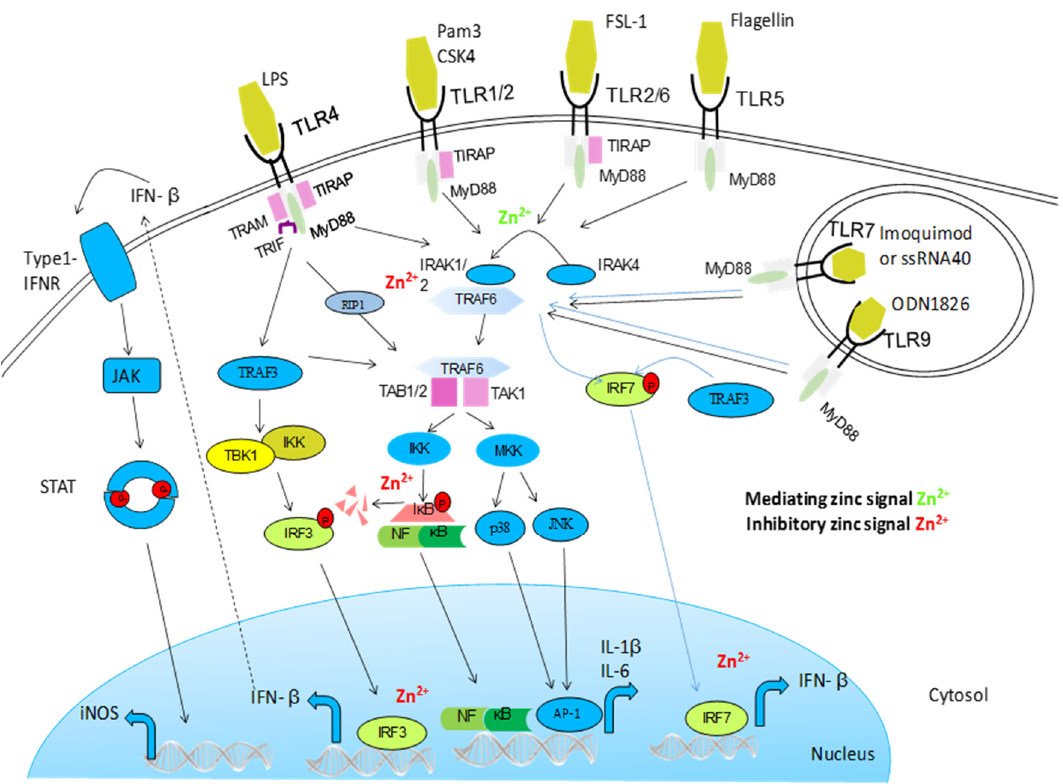
Figure 1. Activation of Toll-like receptor (TLR) signaling pathways is mediated by a complex array of proteins. When TLRs bind ligands, dimerization of the ectodomain of TLRs is induced, bringing their cytoplasmic Toll/IL-1R domains together, resulting in the recruitment of intracellular adapter proteins and initiation of downstream signaling events. Following this, the Toll–IL-1-resistence (TIR) domains of TLRs engage TIR domain-containing adaptor proteins (either myeloid differentiation primary-response protein 88 (MYD88) or TIR domain-containing adaptor protein inducing IFN β (TRIF) and TRIF-related adaptor molecule (TRAM)). This in turn stimulates downstream signaling pathways that involve interactions between IL-1R-associated kinases (IRAKs) and the adaptor molecules TNF receptor-associated factors (TRAFs), and that lead to the activation of the mitogen-activated protein kinases (MAPKs) JUN N -terminal kinase (JNK) and p38, and to the activation of transcription factors. Two groups of transcription factors are activated downstream of TLR signaling; nuclear factor- κ B (NF- κ B) and interferon-regulatory factors (IRFs). This TLR signaling pathway leads to the induction of proinflammatory cytokines. Zinc influences this pathway on multiple levels. It augments MyD88-dependent signaling whereas inhibiting TRIF-mediated activation of IRF3/7. It has been shown that zinc inhibits IRAK thereby inhibiting further signal transductions. In vitro, zinc also directly impaired LPS-induced IKK activity [45].